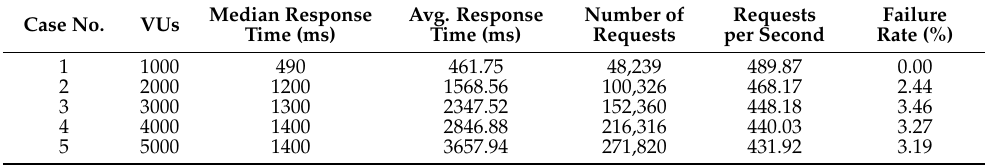
Table 1. Performance for 0-policy routing.